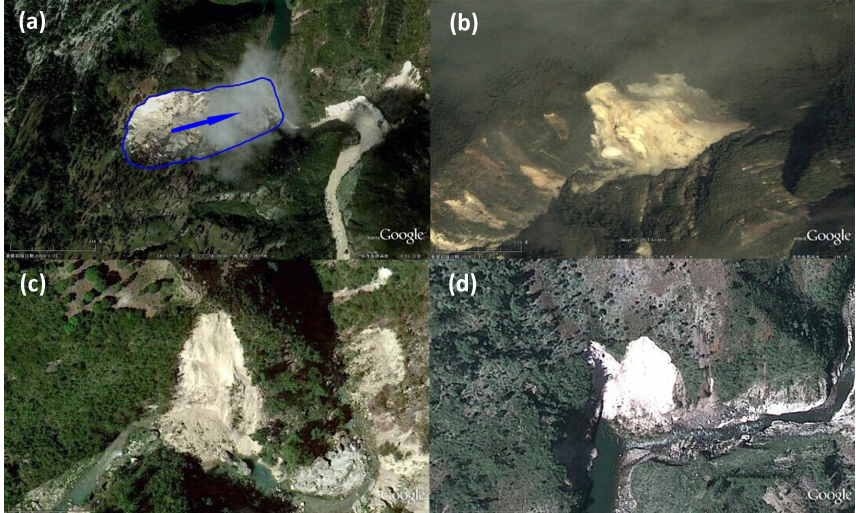
Figure 9. Several rock slides triggered by the Haiti earthquake. (a) shows a rock slide located at 18 ◦ 17 0 50.27 00 N, 72 ◦ 38 0 38.01 00 W; the image was taken on 25 January 2010 (upward is west). (b) is located at 18 ◦ 21 0 38.49 00 N, 72 ◦ 42 0 14.65 00 W; the image was taken on 14 January 2010 (upward is north). (c) is located at 18 ◦ 19 0 25.09 00 N, 72 ◦ 39 0 07.99 00 W; the image was taken on 25 January 2010 (upward is west). (d) is located at 18 ◦ 27 0 20.60 00 N, 72 ◦ 24 0 19.85 00 W, and the image was taken on 13 January 2010 (upward is